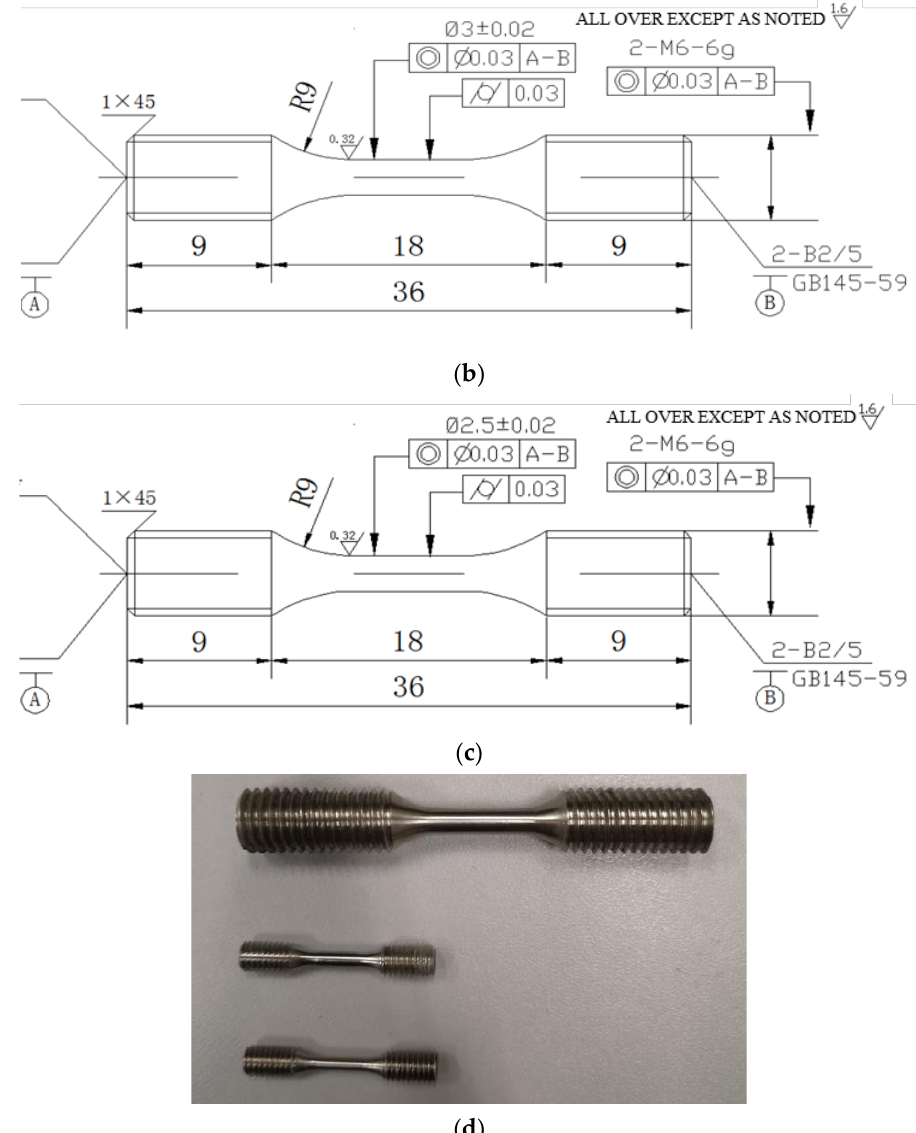
Figure 2. Test pieces of different sizes. ( a ) Standard test piece with a diameter of 5 mm, ( b ) round bar test piece with a diameter of 3 mm, ( c ) miniature test piece with a diameter of 2.5 mm, and ( d ) comparative photograph of the three kinds of test pieces.